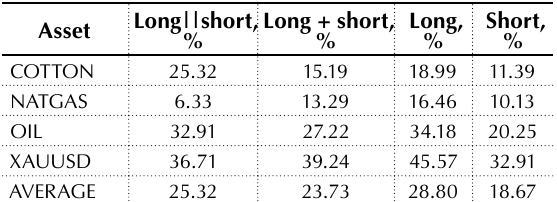
Table 1. Percentage of weeks with profit factor > 1 for Expert Advisors running with constant